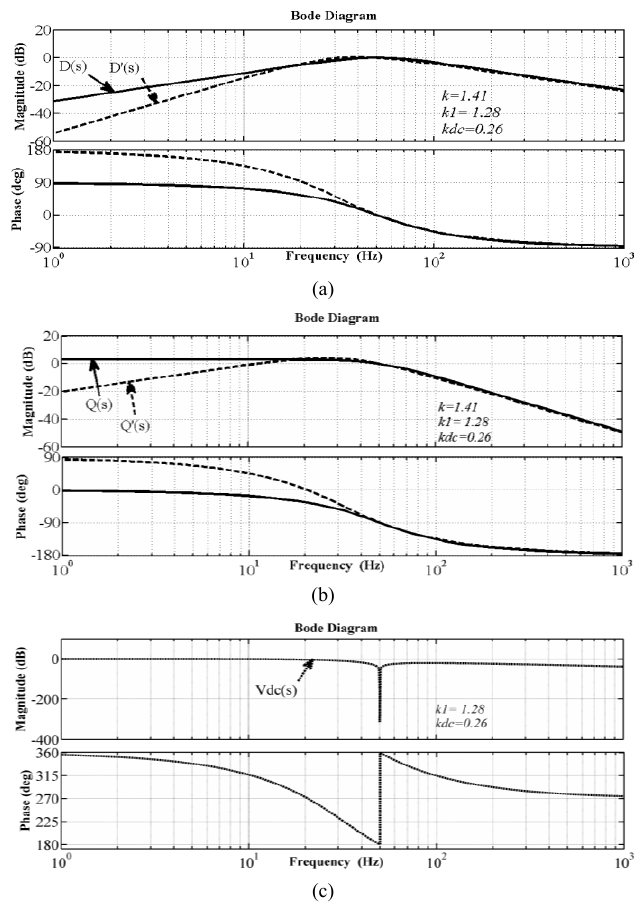
Fig. 4. Comparison of the frequency response for the transfer function (a) D(s) and 𝐷 ′ (𝑠) (b) Q(s) and 𝑄 ′ (𝑠) (c) V dc (s)